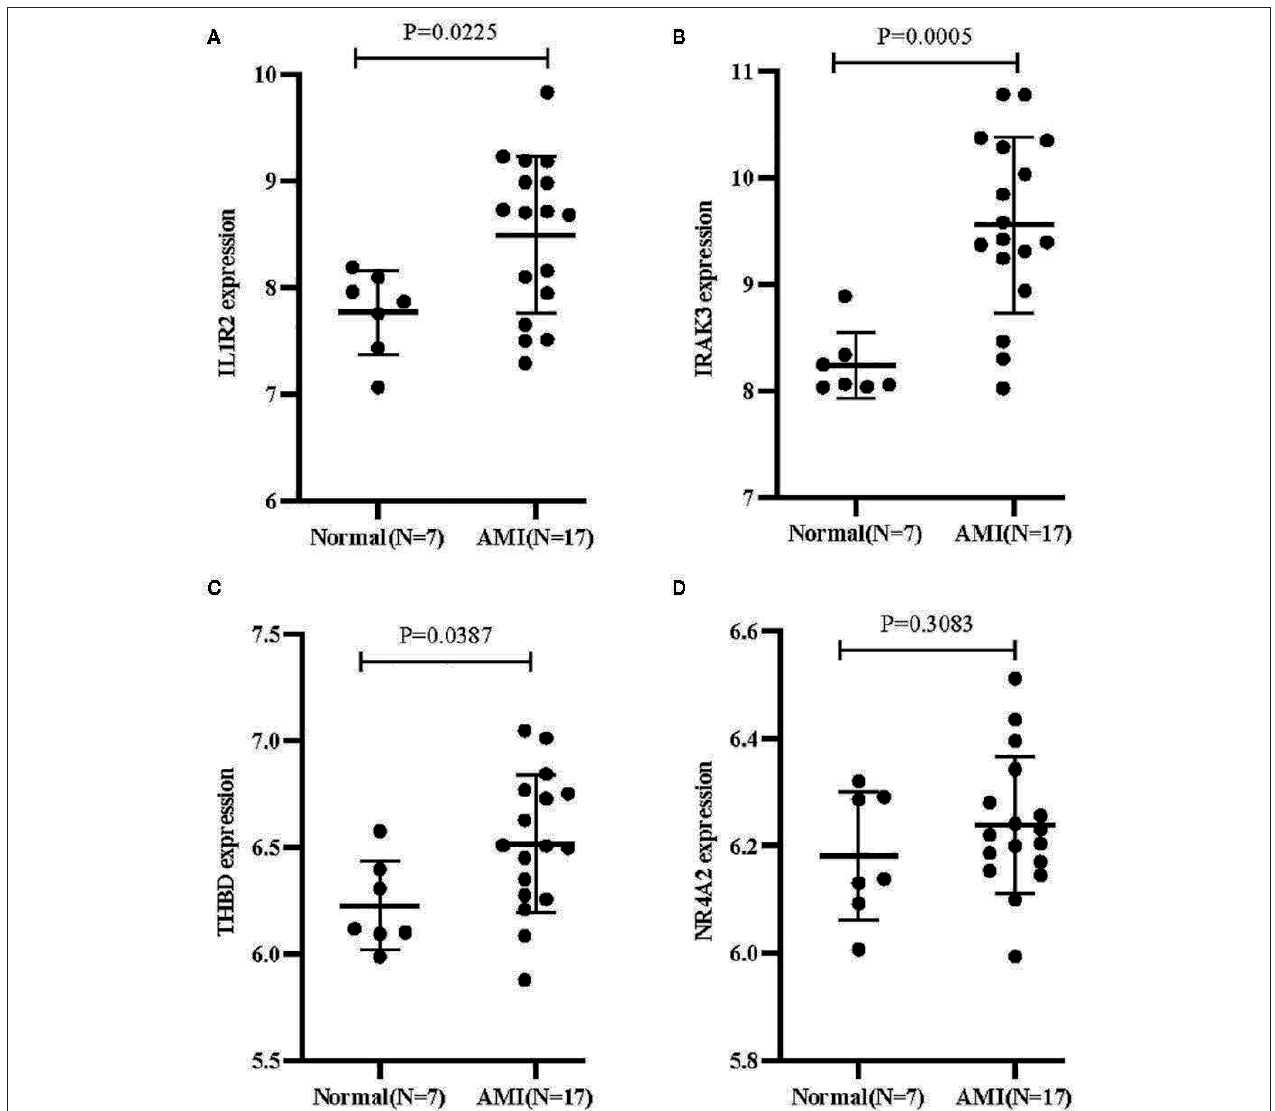
FIGURE 4 | Validation of the expression of diagnostic biomarkers in the GSE60993 dataset. (A) IL1R2; (B) IRAK3; (C) THBD; (D)